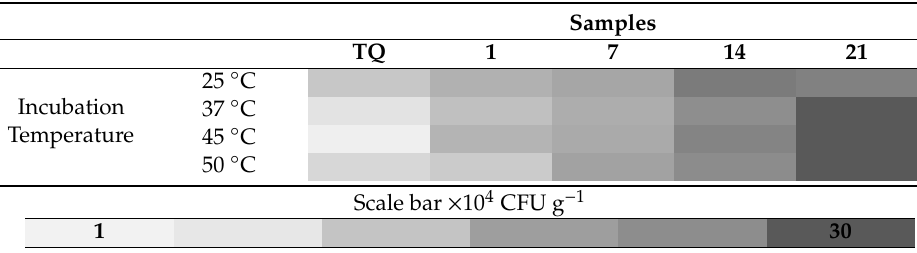
Table 1. Heat map reporting of colony-forming units (CFU) g − 1 in each site for each temperature.